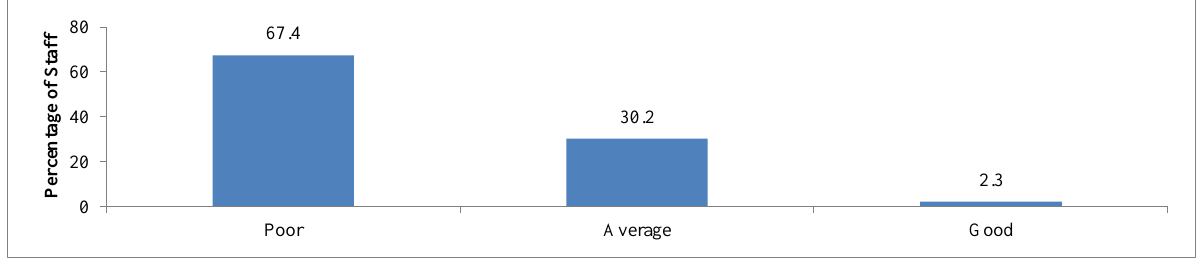
Figure 2: Staffs’ view on Quality of Training at Telkom Kenya